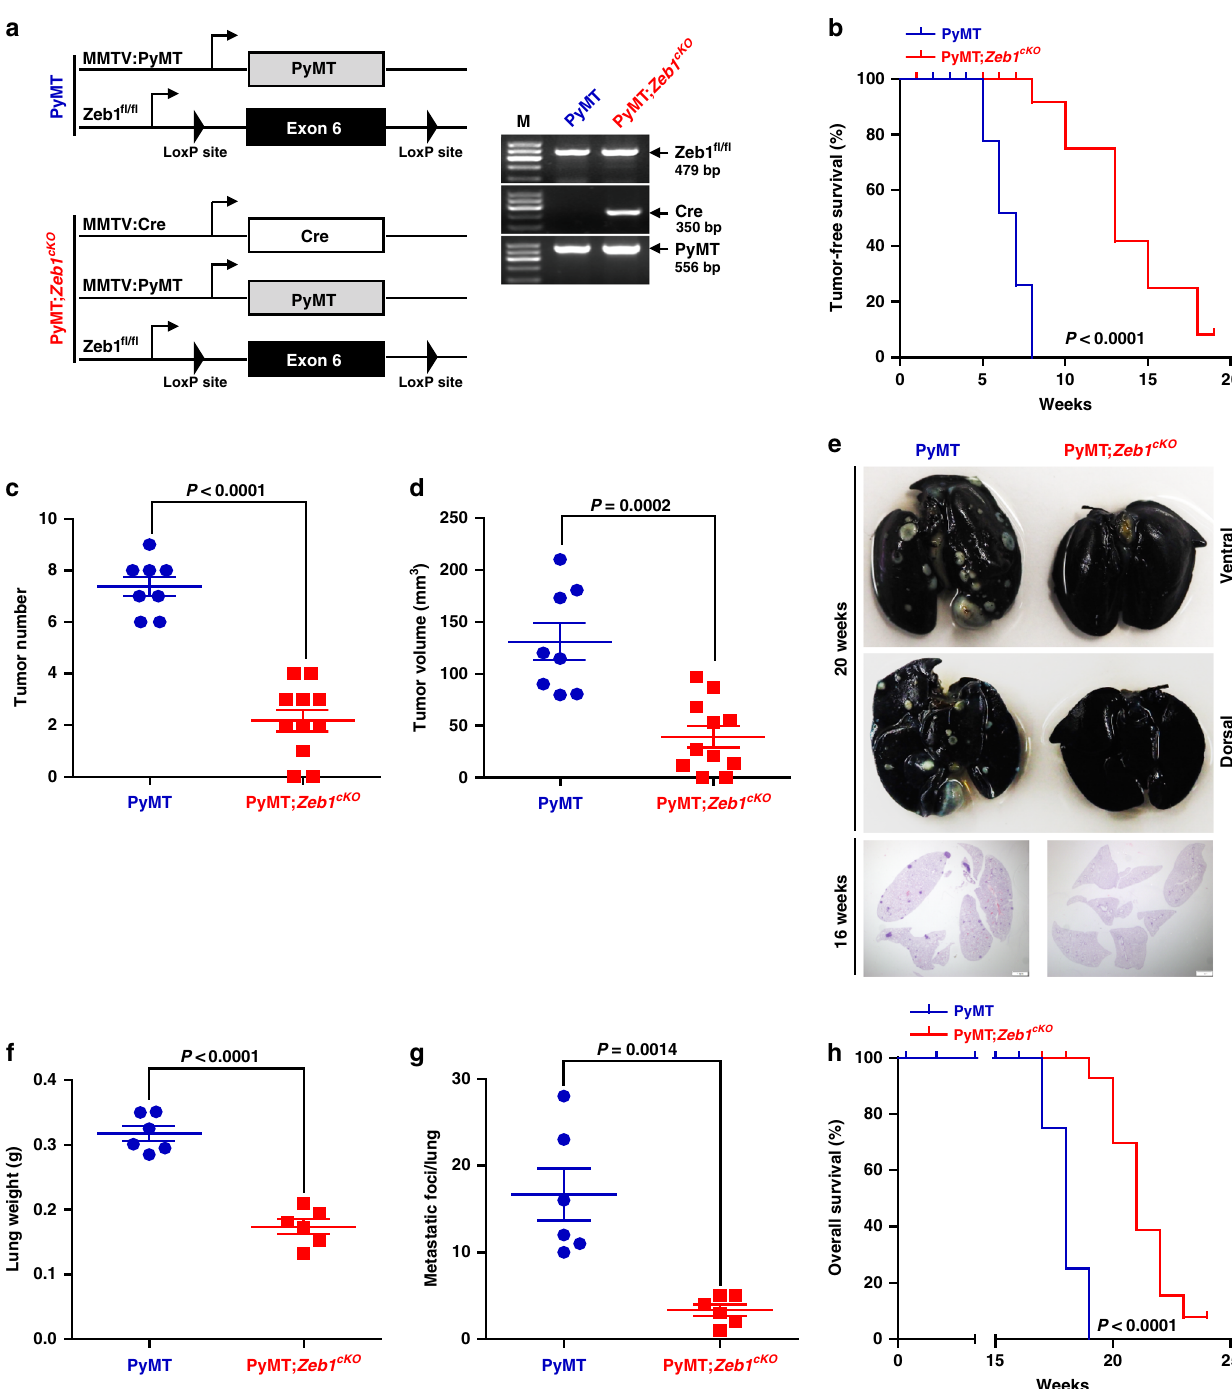
Fig. 1 Zeb1 depletion reduces tumor development and metastasis in breast cancer. a Scheme of the genetic mouse models for breast cancer. The color code (blue, PyMT; red, PyMT; Zeb1 cKO ) is used for all results. b Tumor-free survival ( n = 8 PyMT, 11 PyMT; Zeb1 cKO ). c Tumor number ( n = 8 PyMT, 11 PyMT; Zeb1 cKO ). d Tumor volume ( n = 8 PyMT, 11 PyMT; Zeb1 cKO ). e Representative images of lung metastases at 16 – 20 weeks. Scale bars, 1 mm. f Lung weight ( n = 6 PyMT, 6 PyMT; Zeb1 cKO ). g Metastatic lung foci ( n = 6 PyMT, 6 PyMT; Zeb1 cKO ). h Overall survival ( n = 8 PyMT, 12 PyMT; Zeb1 cKO ). Indicated P -values were calculated using log-rank test (Mantel – Cox) with multiple comparisons in b , h or two-tailed unpaired Student ’ s t -test in c , d , f , g . Data are presented as mean ± SEM in c , d , f , g . Dots depict individual samples in c , d , f , g . Data are representative of at least fi ve ( b – h ) independent experiments. Source data are provided as a Source Data fi